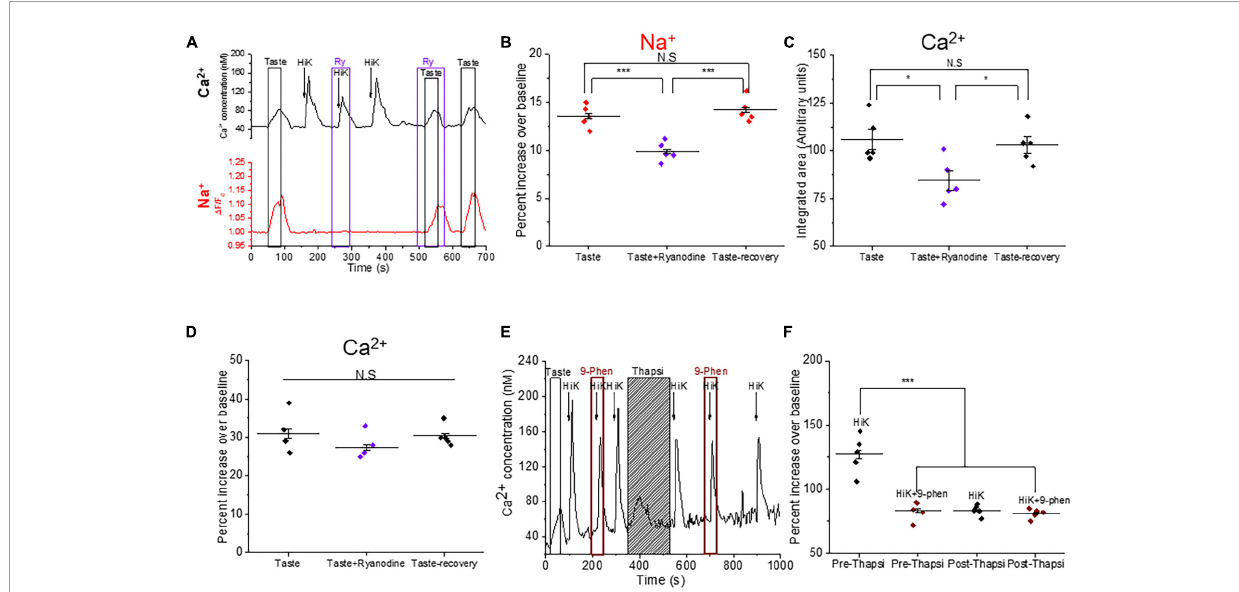
FIGURE7 Calcium-induced calcium release (CICR) signaling via ryanodine receptors contributes to the taste-evoked signaling in BR cells. (A) Representative dual Ca 2 + (black line) and Na + (red line) imaging traces from BR cells showing ryanodine (20 µ M) inhibited the taste-evoked sodium and calcium responses. (B) The taste-evoked sodium responses were significantly reduced by ryanodine (20 µ M) (( F ( 2 , 12 ) = 20.99, p = 0.00012, n = 5 cells from 3 mice). Ryanodine significantly reduced the magnitudes of the taste-evoked calcium signals ( C , F ( 2 , 12 ) = 5.66, p = 0.02), but did not affect the amplitudes of the taste-evoked calcium responses ( D , F ( 2 , 12 ) = 1.29, p = 0.31, n = 5 cells from 3 mice). (E) A representative calcium imaging trace in BR cell showing CICR signaling affects TRPM4 activity. (F) 9-phenanthrol partially inhibited the calcium influx signals generated by 50 mM KCl in some BR cells. After store depletion by thapsigargin, peak amplitudes of the calcium responses due to 50 mM KCl were comparable to the peak amplitudes of the calcium responses during application of 9-phenanthrol. TRPM4 inhibition no longer affected the calcium signals after store